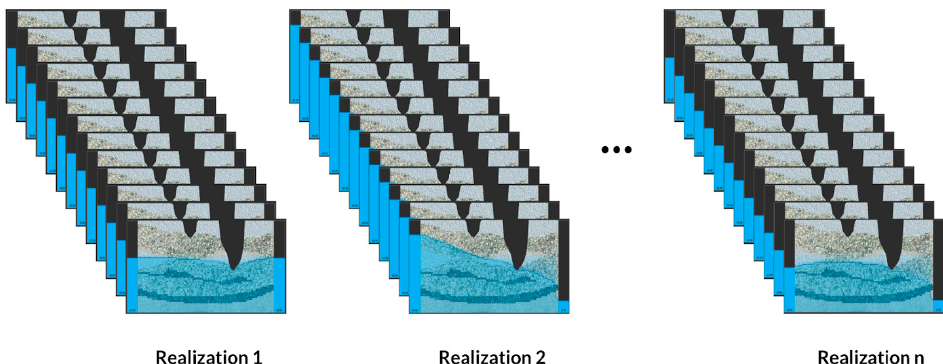
Figure 8. ParFlow-based Sandtank is leveraged to generate ensembles of realizations covering the adjustable parameters spanning dimension.